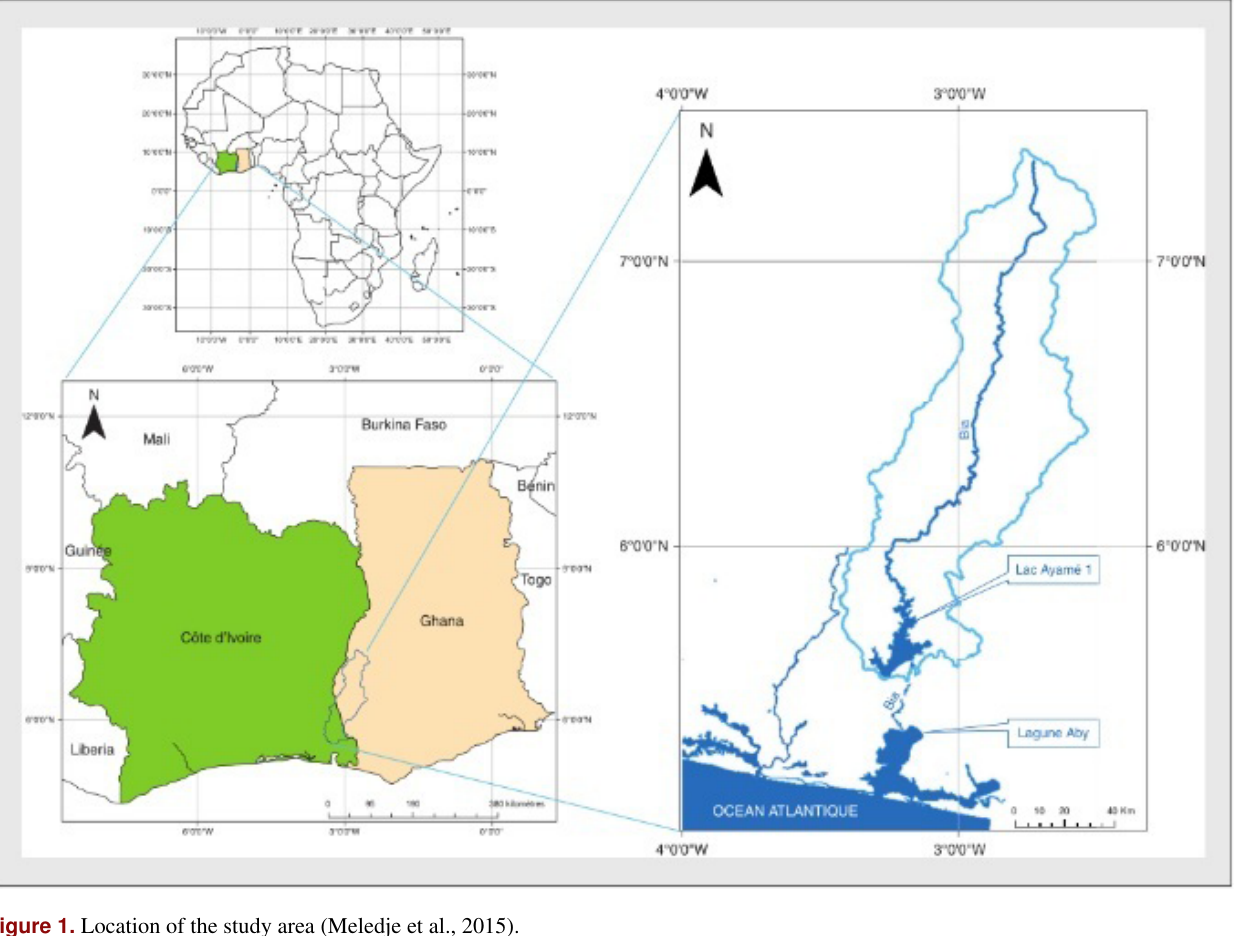
Figure 1. Location of the study area (Meledje et al., 2015).